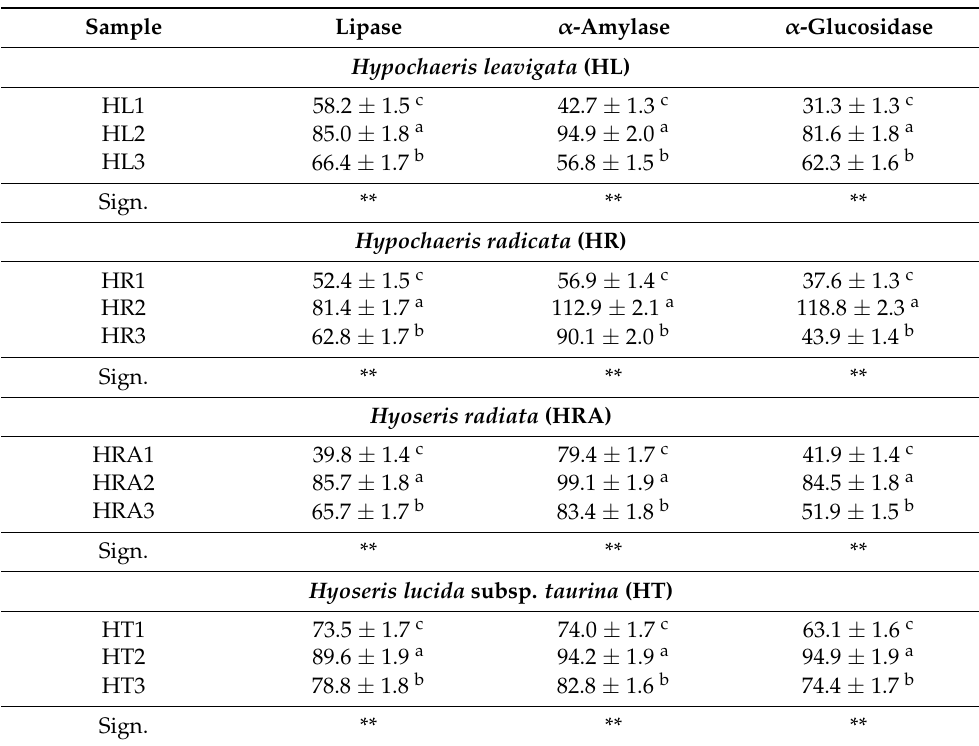
Table 5. Lipase, α -amylase, and α -glucosidase inhibitory activity [IC 50 ( µ g/mL)] of Hypochaeris and Hyoseris